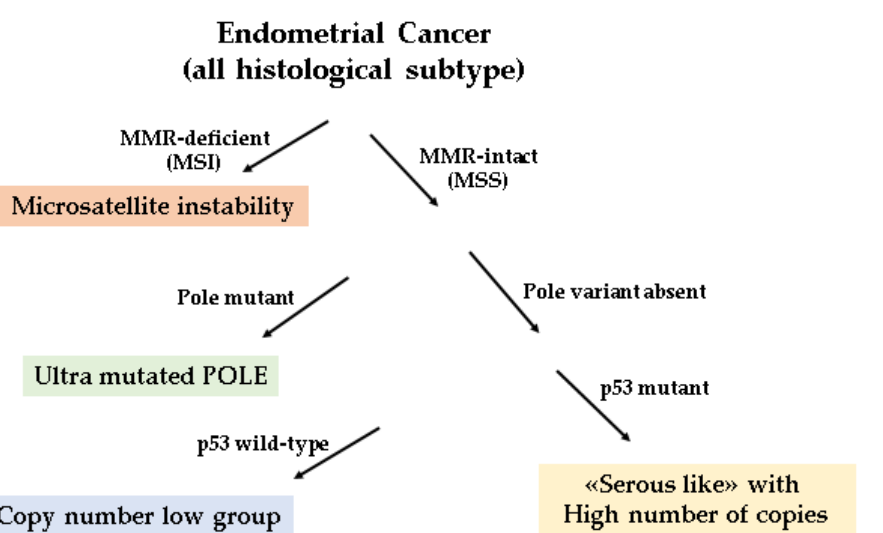
Figure 1. Endometrial Cancer IHC valuation: The first assessment is for the presence of mismatch repair (MMR); the second for polymerase- ε (POLE) exonuclease domain mutations (EDMs); and the third for protein 53 (p53).